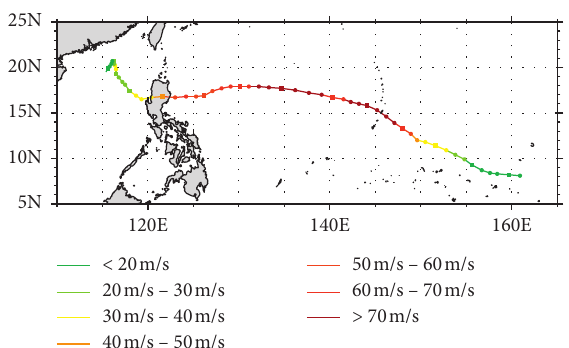
Figure 1: Intensity and track of Yutu from JTWC Best-Track data between 1800 UTC 20 Oct 2018 and 0600 UTC 3 Nov 2018. Po- sitions at 0000 UTC are marked by squares, and the colors of the track indicate the maximum wind speed at 10m level above the sea